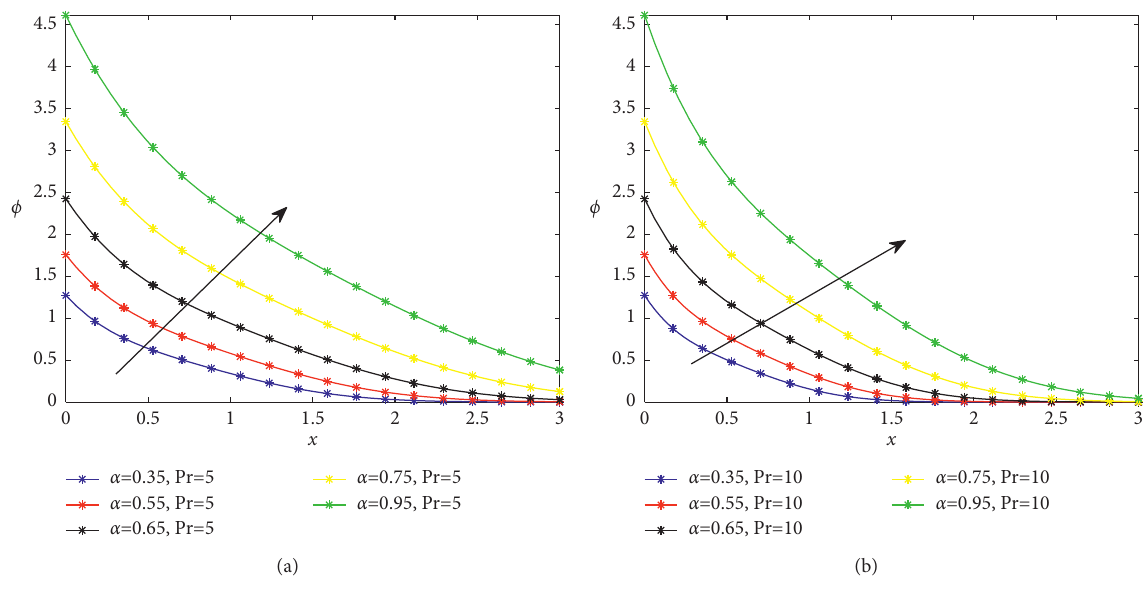
Figure 6: Temperature for different values of order α